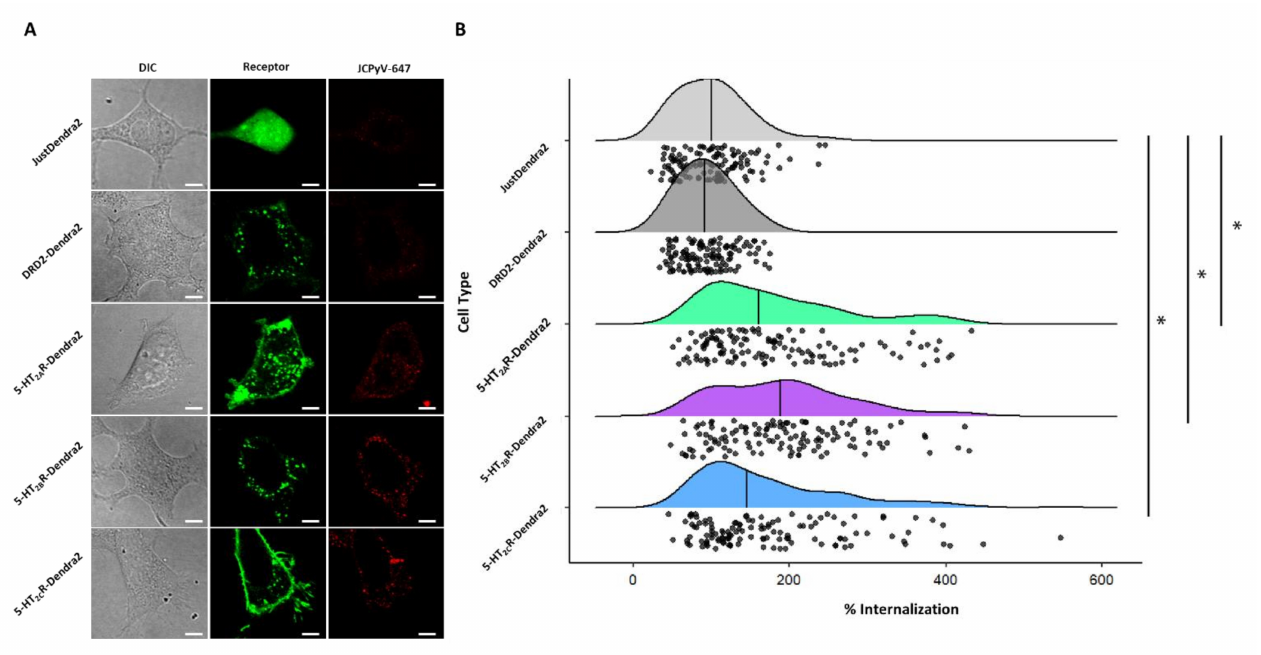
Figure 5. JCPyV internalization significantly increases in 5-HT 2 R subtype-expressing stable cells. Cells stably expressing 5-HT 2 R subtypes were plated and infected with JCPyV-647 (MOI = 3 FFU/cell) on ice for synchronized virus attachment and further incubated at 37 ◦ C for 1.5 h to allow for viral entry. After fixation, cells were visualized via confocal microscopy using a 60 × objective lens. ( A ) Images demonstrate DIC (grey), Dendra2 expression (green), and JCPyV-647 (red) in individual samples. Using Image J, masks were drawn for Dendra2- expressing cells in individual samples and JCPyV internalization was quantified using the relative fluorescence intensity of JCPyV-647 within individual cells for at least 30 cells of each sample per replicate for 3 independent replicates. ( B ) Quantified data are shown as a raincloud plot with individual data points indicated in black and the distribution shown with the median indicated by a black line. The Wilcoxon Rank Sum Test was used to compare the percent internalization of each cell type. The percent internalization of 5-HT 2A R-Dendra2, 5-HT 2B R-Dendra2, and 5-HT 2C R-Dendra2 subtypes was significantly different compared to DRD2-Dendra2 and JustDendra2. There was no significant difference between percent internalization of JCPyV between 5-HT 2 R subtypes. The symbol * signifies p < 0.01. Scale bars = 5 µ